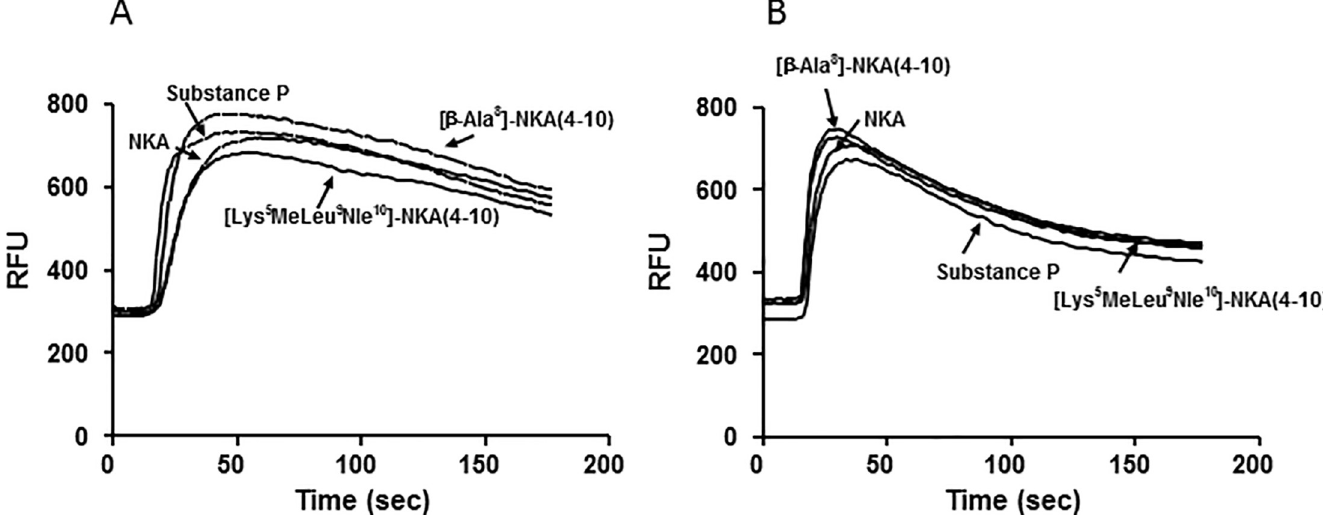
Fig 5. Representative calcium traces for NKA, substance P, [Lys 5 ,MeLeu 9 ,Nle 10 ]-NKA(4–10) and [ β -Ala 8 ]-NKA(4–10) using human recombinant NK2 and NK1 receptors. Compounds were tested at the EC 50 concentration. Data are expressed as relative fluorescence units (RFU) measured over a period of 200 seconds. A: NK2 receptors, B: NK1 receptors.